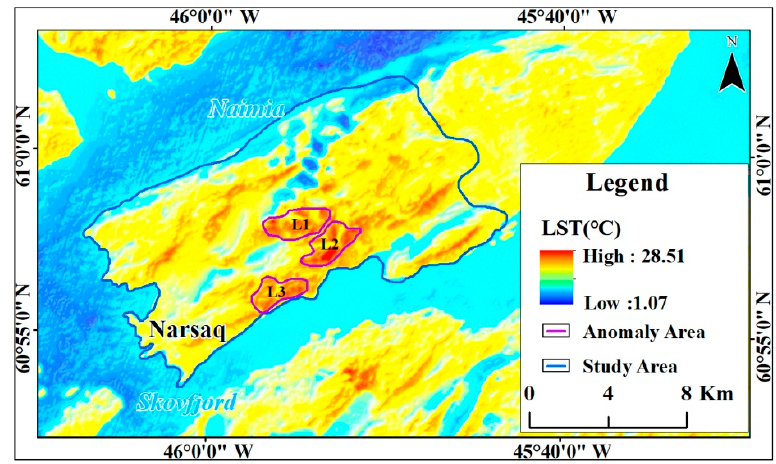
Figure 13. Surface temperature inversion map. Table 5. Surface temperatures in areas of thermal anomalies.